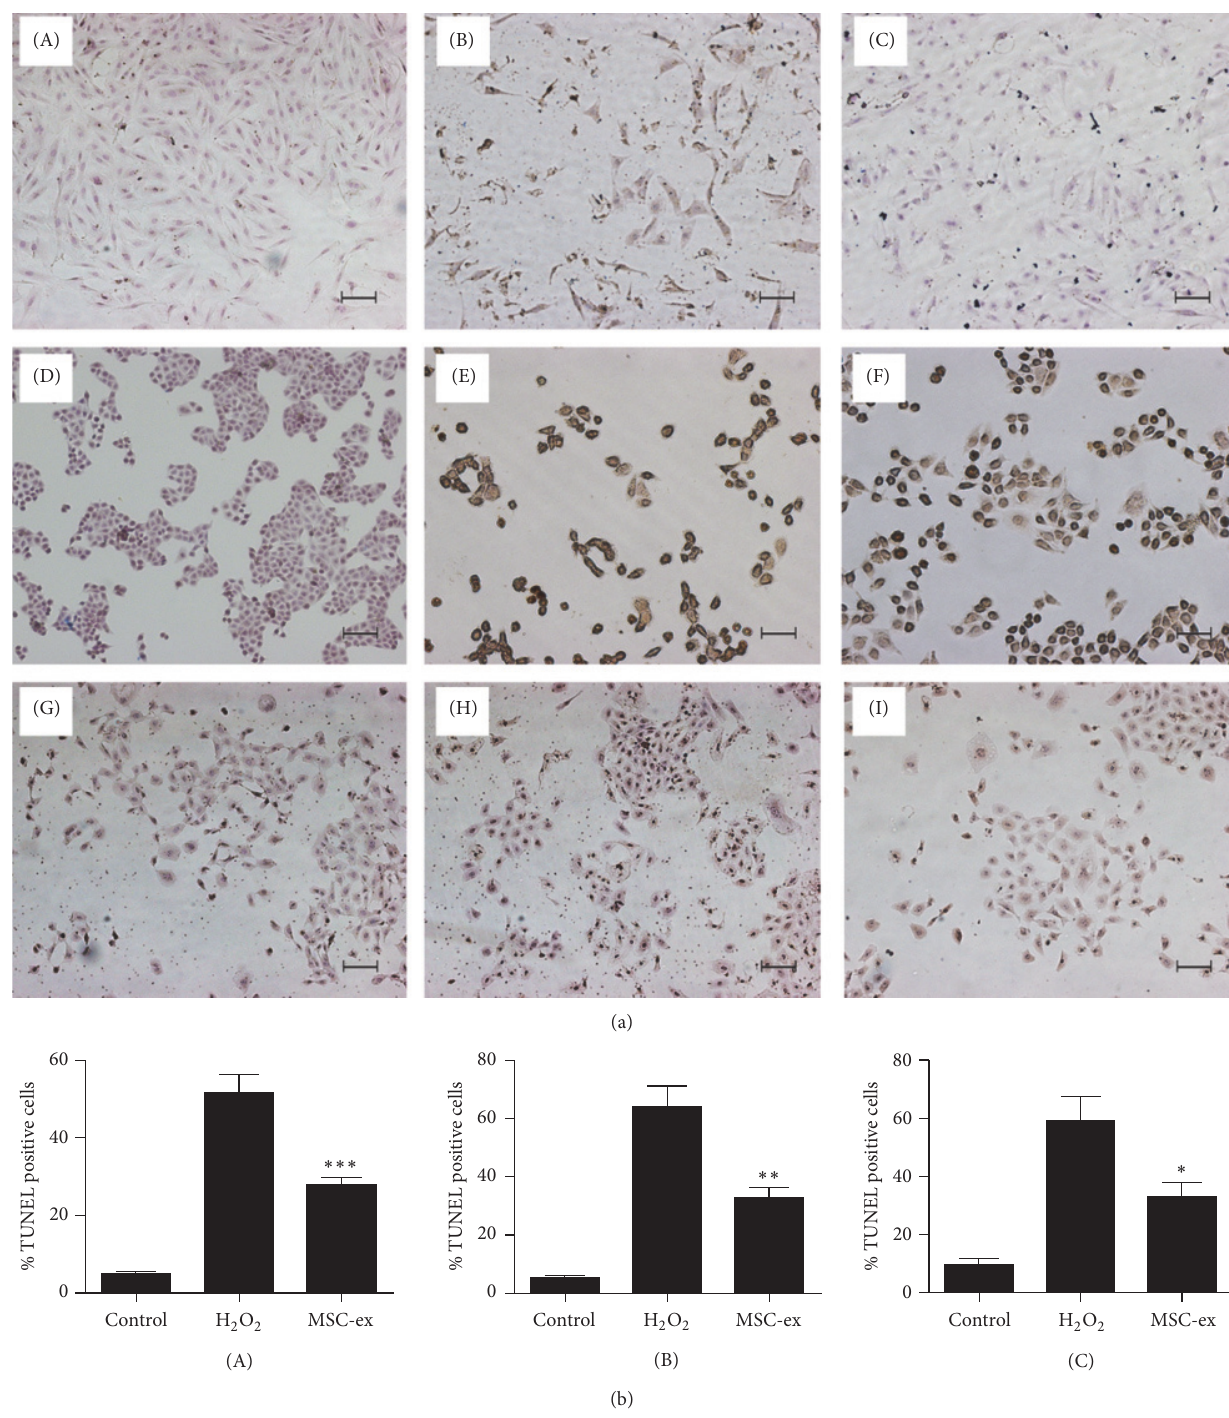
Figure 5: HucMSCs-exosomes inhibit H 2 O 2 -induced apoptosis. (a) TUNEL staining. H9C2(2-1), HL-7702, and NRK-52E cells were pretreated with hucMSCs-exosomes (800 𝜇 g/mL) for 24 hours, followed by exposure to H 2 O 2 (300, 300, and 500 𝜇 M) for different time points (24, 6, and 6 hours). (A–C) H9C2(2-1); (D–F) HL-7702; and (G–I) NRK-52E. Control (A, D, and G); H 2 O 2 (B, E, and H); hucMSCs-exosomes (C, F, and I). Scale bar: 100 𝜇 m. (b) Quantitative analysis of the percentage of TUNEL-positive cells. ∗ 𝑝 < 0.05 compared to H 2 O 2